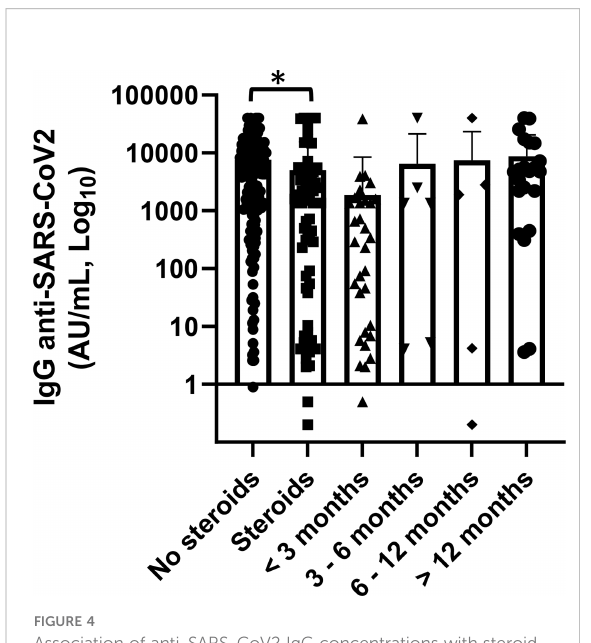
FIGURE 4 Association of anti-SARS-CoV2 IgG concentrations with steroid therapy and distance from the end of steroid treatment. Patients treated with steroid therapy (n = 70) showed signi fi cantly lower levels of anti-SARS-CoV-2 IgG than patients with did not receive them (p = 0.045). Differences assessed by t-test, (*) p < 0.05. Error bars correspond to standard deviation calculated from the mean of relative concentrations. Values below the black line correspond to anti-SARS-CoV-2 IgG lower than 10.0 AU/ml, and values of 0 AU/ml were not shown since the graph is on a log